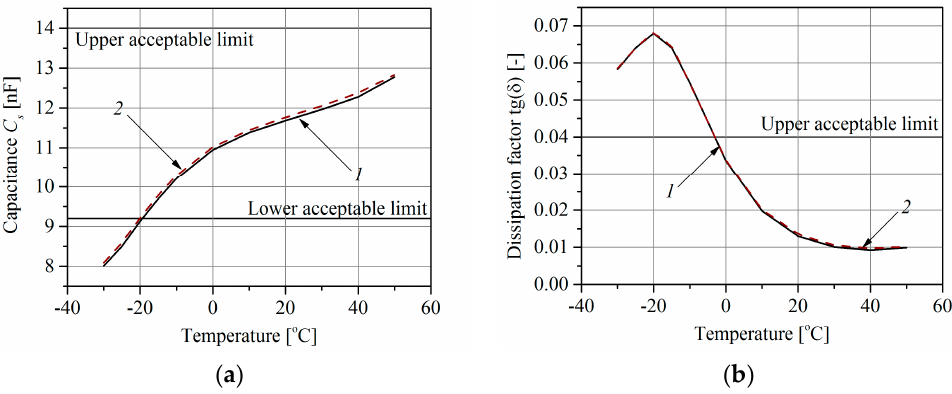
Figure 8. The influence of temperature on: ( a ) the equivalent capacitance C s of a piezoelectric polymer sensor; ( b ) dissipation factor tg ( δ ), for 1: sensor with connecting cable, 2: sensor without connecting cable.